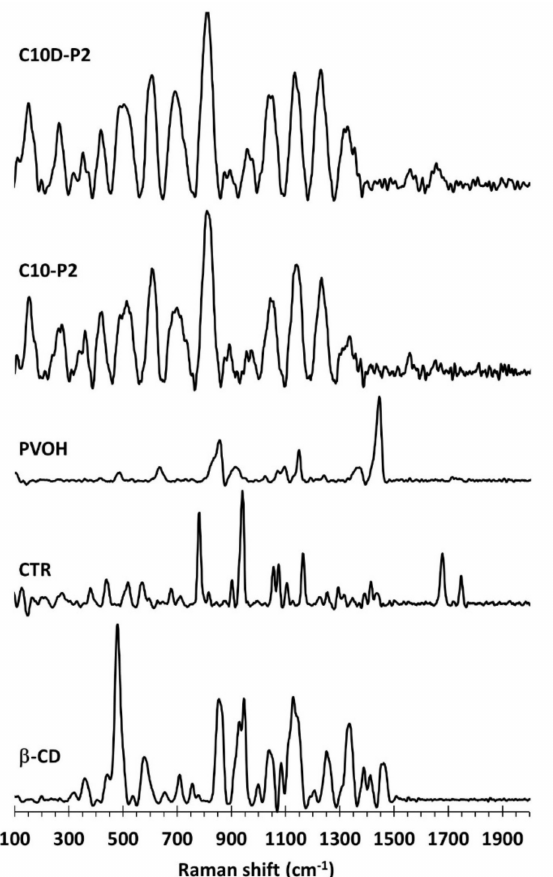
for OCH side group deformational of D -glucopyranose units, 757 cm − 1 for D -glucopyranose ring breathing mode, 709 cm − 1 for CH out of plane bending, 575 cm − 1 for OH wagging, 479 cm − 1 for skeletal vibrations of amylose, 439 cm − 1 for CH stretching, 356 cm − 1 for OH stretching, 318 cm − 1 for external C–OH out of plane bending of glucopyranose units, and 155 cm − 1 for the breathing motions of oxygen atoms in the macrocyclic ring. These results were in agreement with the literature [89–92].